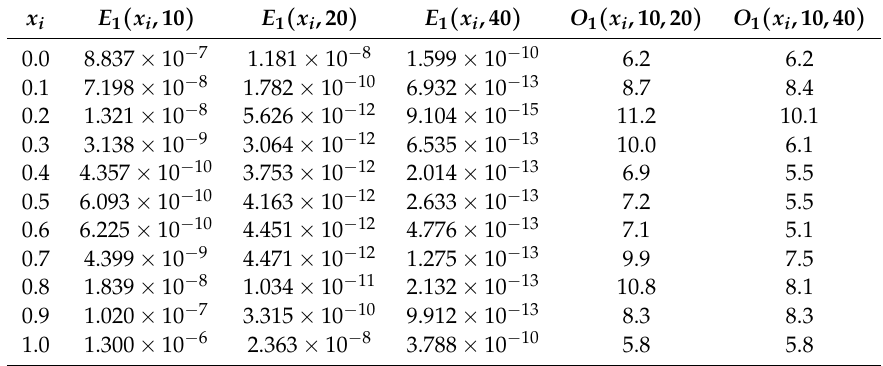
Table 3. The absolute errors of the first order derivatives of y 1 at the knots and the numerical convergence